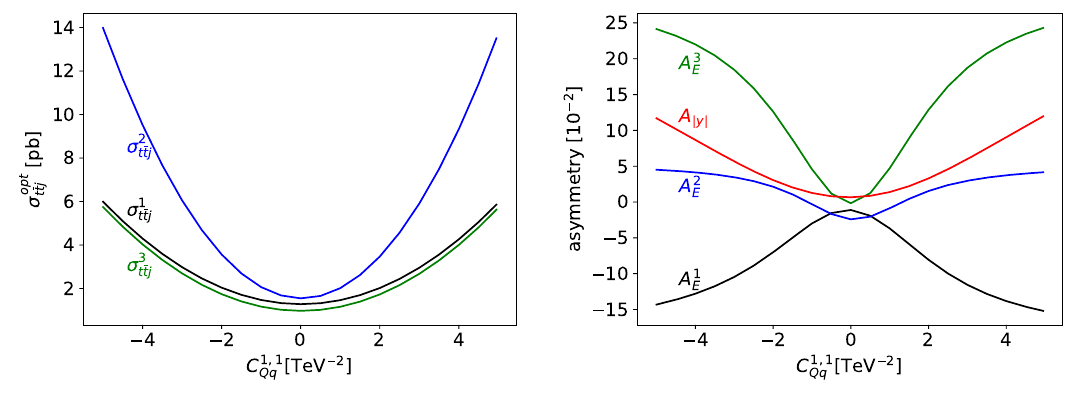
Figure 4 . Dependence of the optimized cross section (cid:27) opt (right) on the Wilson coe(cid:14)cient C 1 ; 1 the jet angle (cid:18) j as de(cid:12)ned in eq. (2.7).